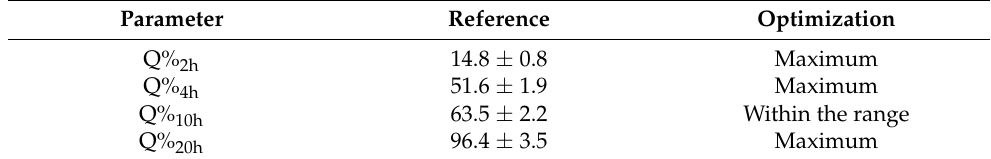
Table 8. Intended response sets in the optimization step based on the results of the reference